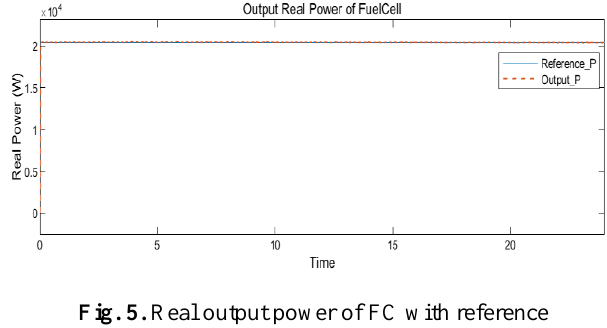
Fig. 5. Real output power of FC with reference